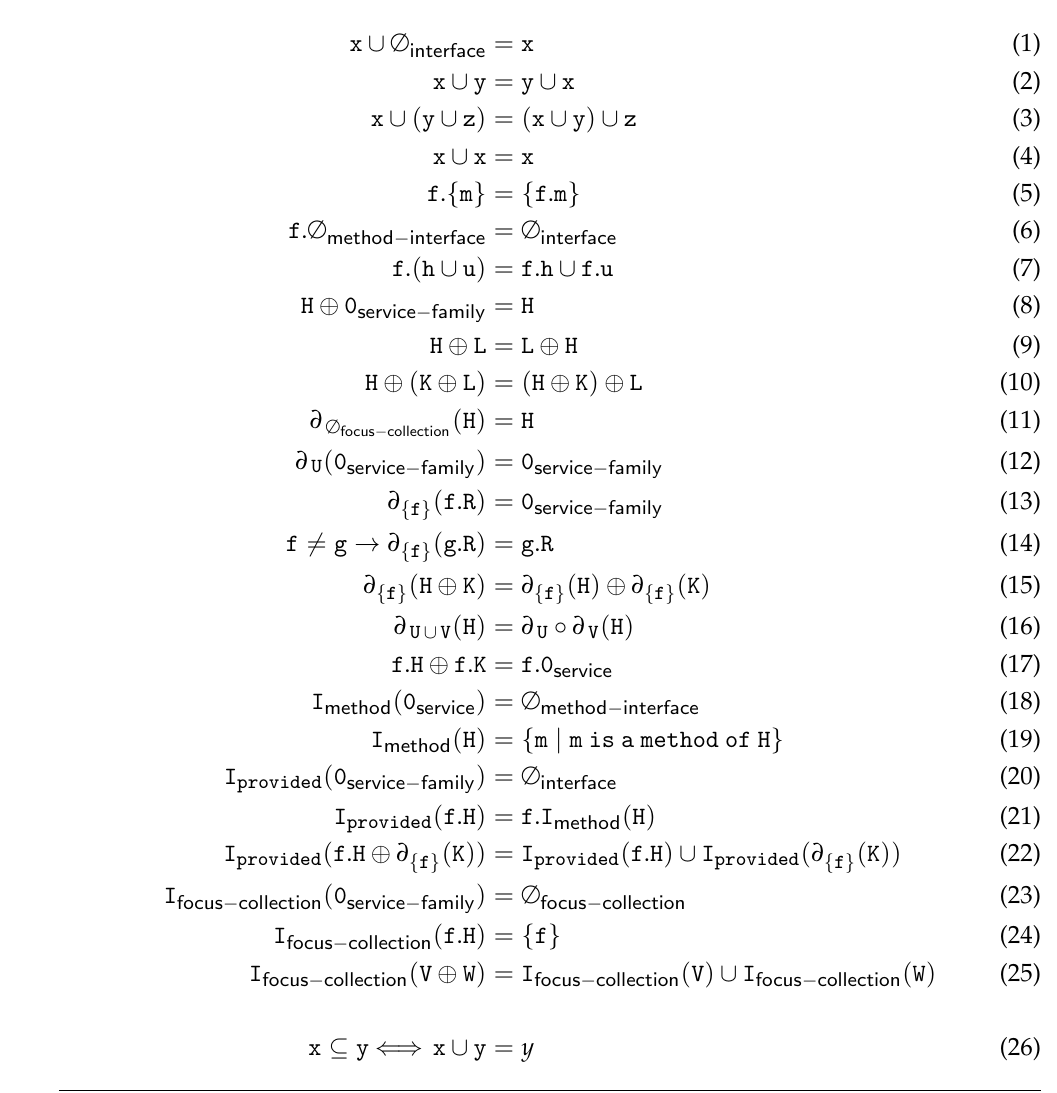
Table 1. Equations for provided interfaces.